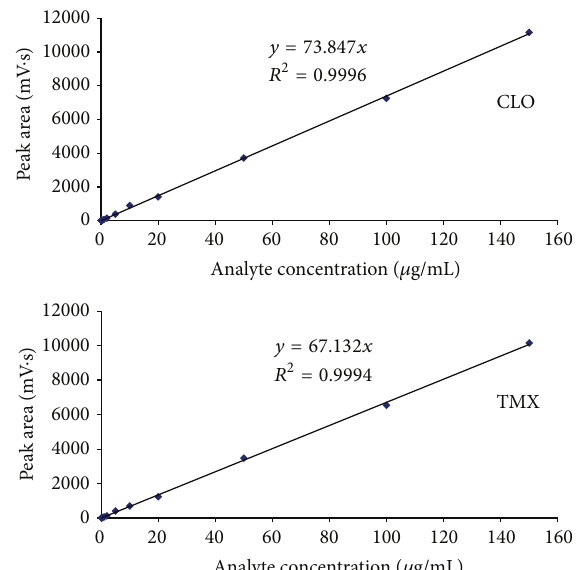
Figure 1: Calibration curves for CLO and TMX determined at 269 nm and at 252 nm, respectively.